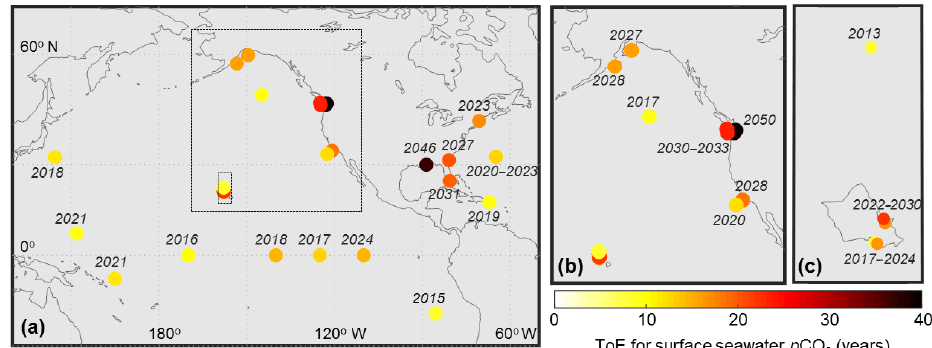
Figure 5. (a) Time of trend emergence (ToE) estimates, i.e., number of years of observations necessary to detect an anthropogenic trend, with insets enlarged for (b) the US west coast and (c) the Hawaiian island of Oahu. ToE is not shown for sites with less than 3 years of observations (Kaneohe, Iceland, BOBOA, M2, SEAK, SOFS, BTM, TAO165E, TAO155W, NH-10, and JKEO). Years shown are the earliest dates of seawater p CO 2 trend detection for each time series, which is the ToE estimate plus the time series start year (Table 1). These years of trend detection and the associated uncertainty are also shown in Table 2. For the pH data sets with long enough time series to calculate ToE (i.e., the circles in Fig. 2), there is no significant difference between the ToE of p CO 2 and pH.